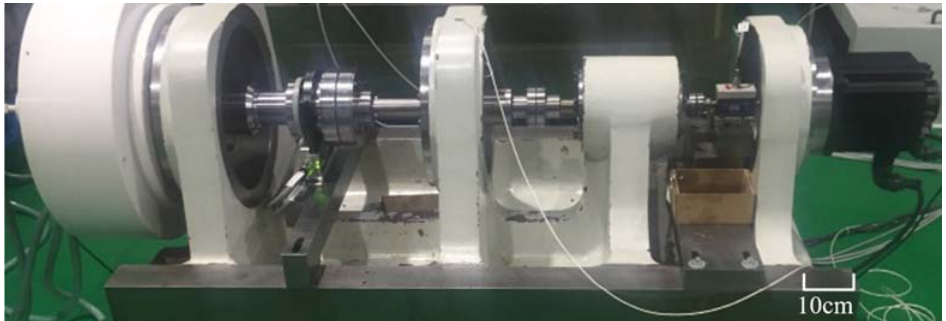
Figure 1. Fatigue life test system of RV Reducer.